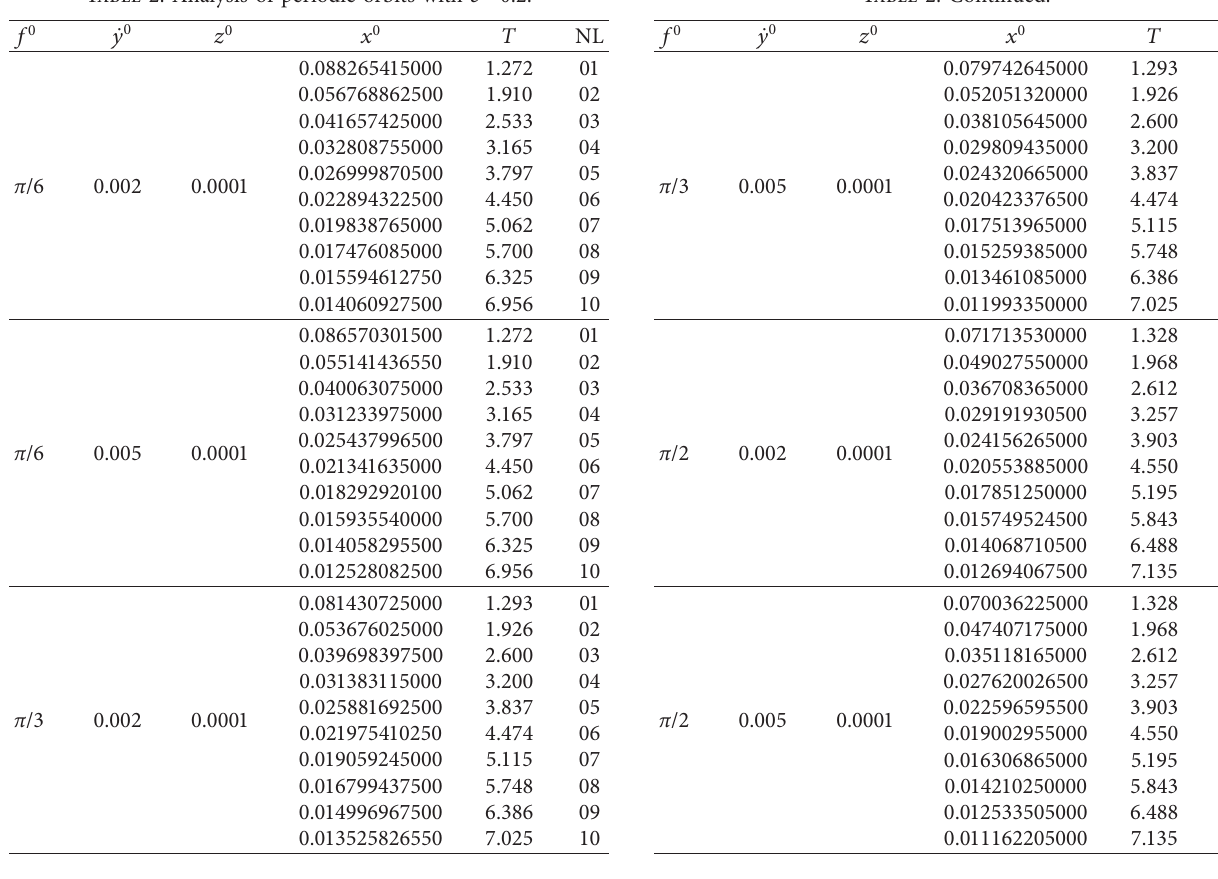
Figure 10: Variation in the initial position of deputy satellite and orbital period when e � 0 . 2. (a) Velocity _ y 0 � 0 . 002. (b) Velocity _ y 0 � 0 . 005. Table 2: Analysis of periodic orbits with e �